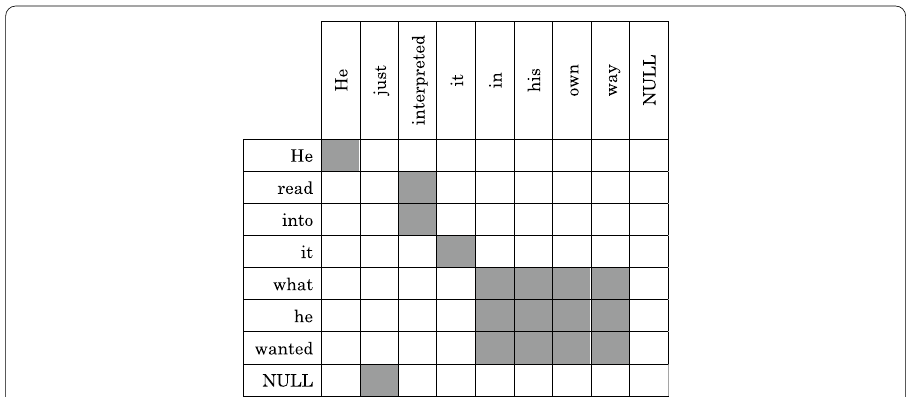
Fig. 2 Alignment Example for Textual Entailment (Wang et al. 2013)